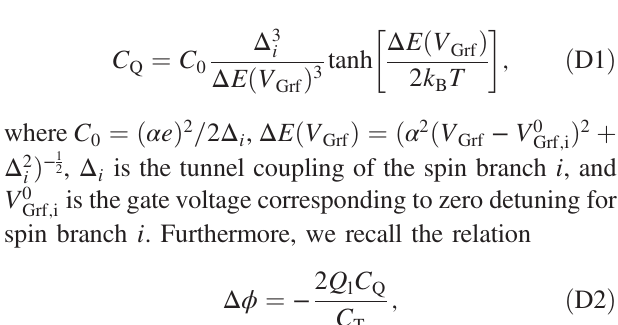
at three magnetic Grf